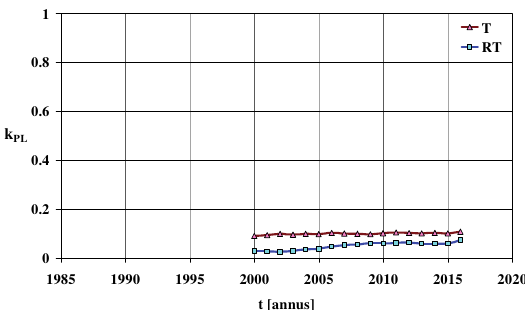
Fig. 8. Share of annual emission in Poland comparing to the annual emission in the European Union for non-methane volatile organic com- Fig. 12. Share of annual emission in Poland comparing to the annual pounds: for total emission – T and for emission from motor emission in the European Union for particulate matter PM2.5: for total vehicles – RT in years 1990–2016 emission – T and for emission from motor vehicles – RT in years 1990–2016 Figures 13–18 show the share of annual emission from motor vehicles in relation to total annual emission: in